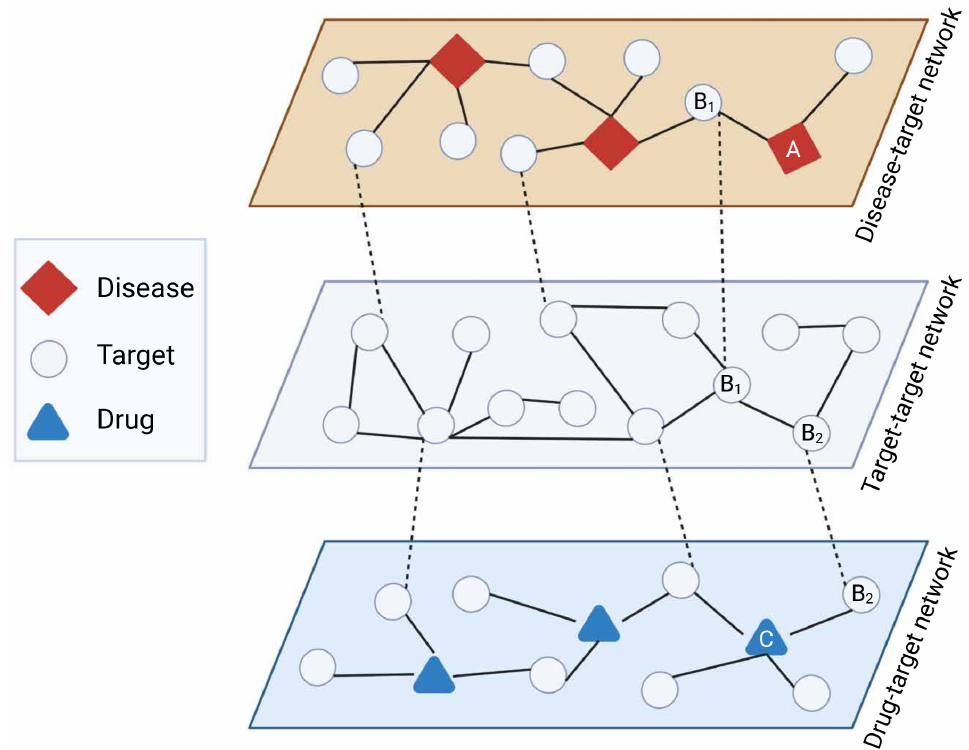
Figure 3. ABC model for network-based drug repurposing. Latent repurposing relationships can be inferred from multiple layers of network-based knowledge such as disease-target (diseasome), target–target (e.g., protein interactome), and drug–target interactions. As an example, disease A has target B 1 exhibiting direct interaction with target B 2 which in turn is targeted by drug C, suggesting drug C might be relevant for disease A (A → B 1 → B 2 → C). Created with BioRender.com (accessed on 2 June 2022).